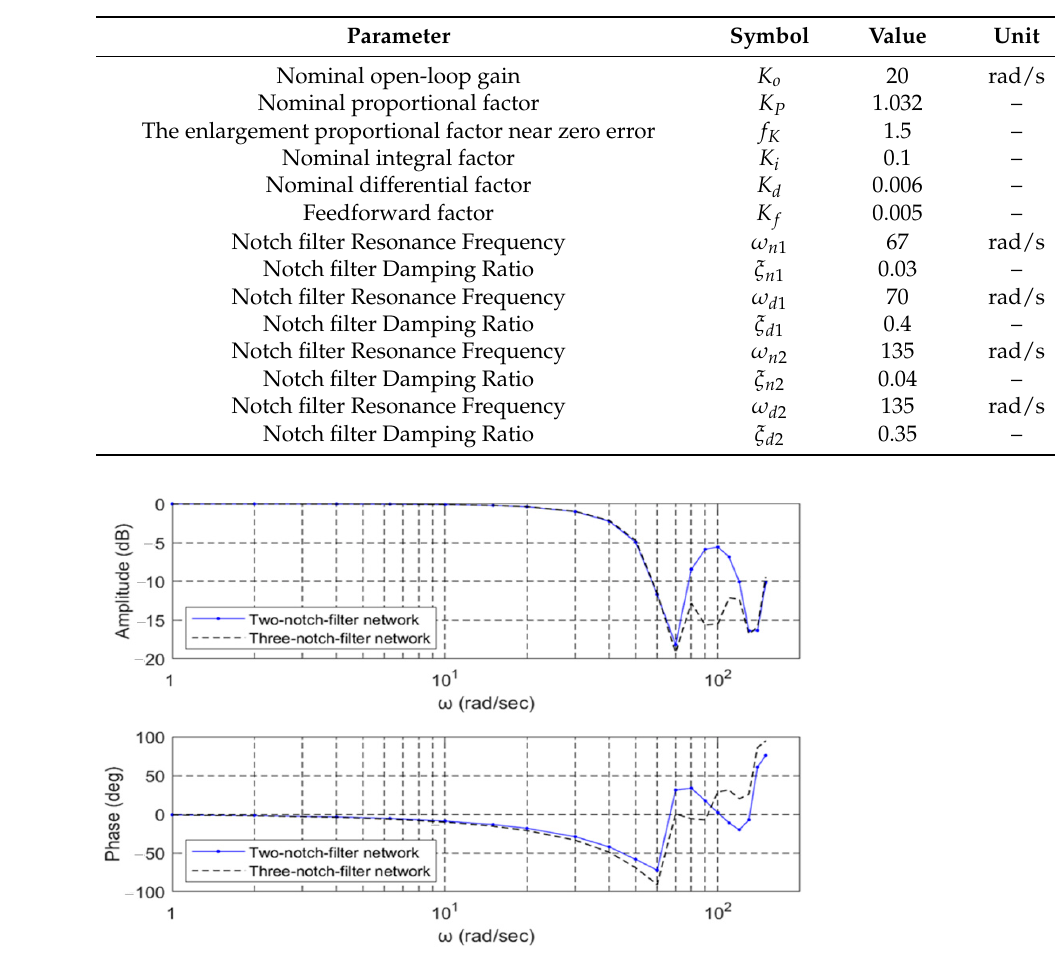
Table 5. The principal parameters of the combined control algorithm.